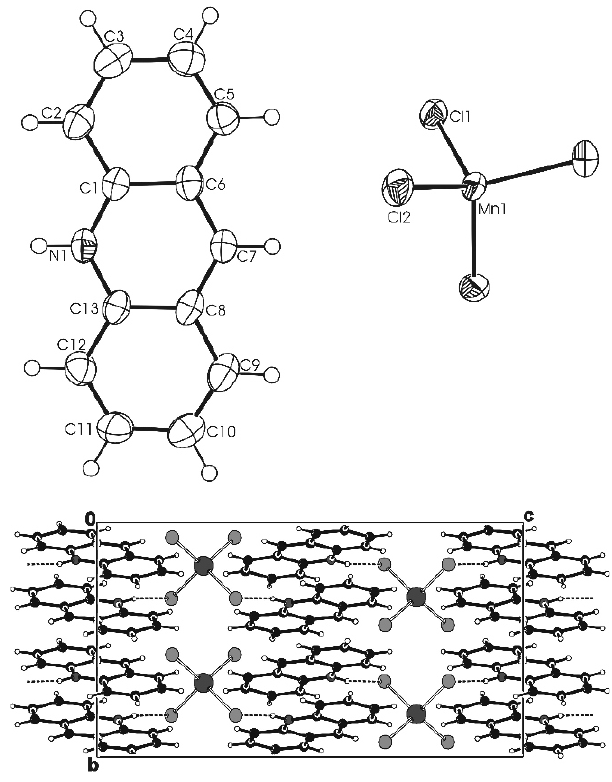
Table 1. Data collection and